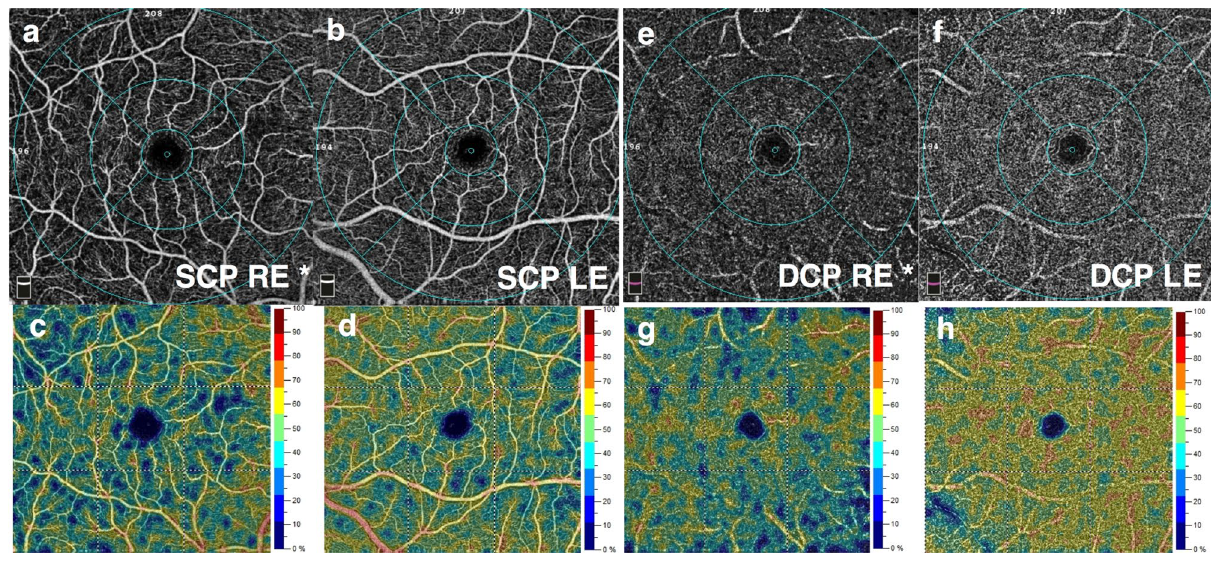
Figure 3. Optical coherence tomography angiograms (top row) and corresponding color mapping of vessel density (bottom row) of the macula of patient No.5 in an eye with CMVR without macular involvement ( a , c , e , g ) and the contralateral normal eye ( b , d , f , h ). Decreased vessel density in the superficial ( a – d ) and deep capillary plexus ( e – h ) was observed in the affected eye compared with the unaffected fellow eye. Asterisks denote the affected eye. LE, left eye; RE, right eye; DCP, deep capillary plexus; SCP, superficial capillary